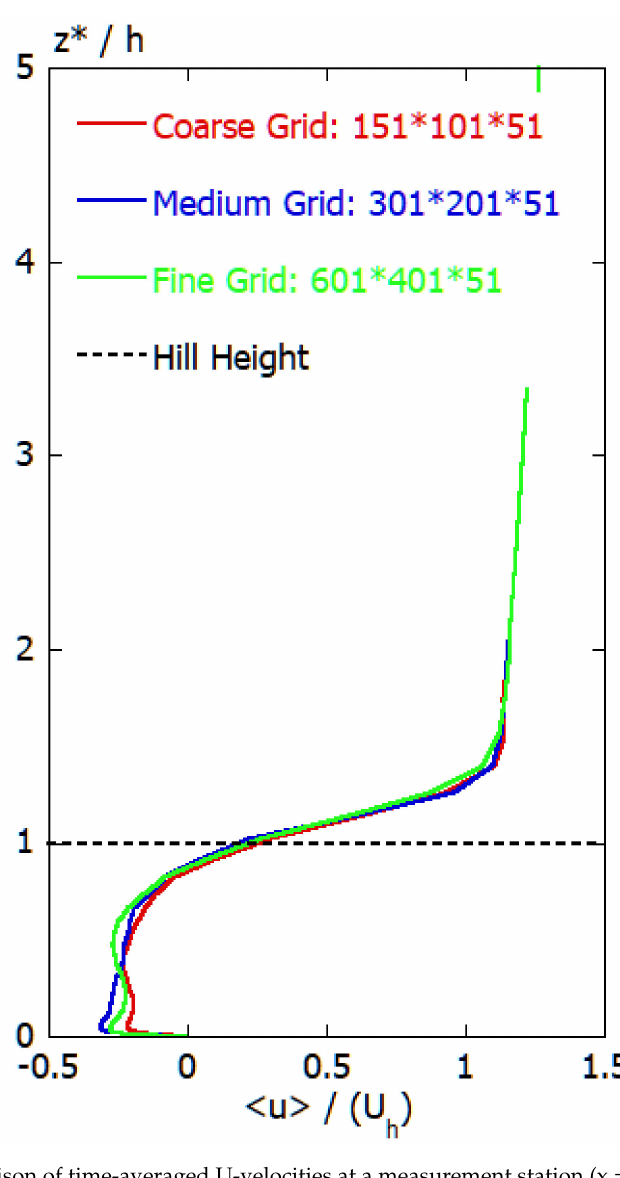
Figure 6. Comparison of time-averaged U-velocities at a measurement station (x = 2 h) behind a steep hill under neutral